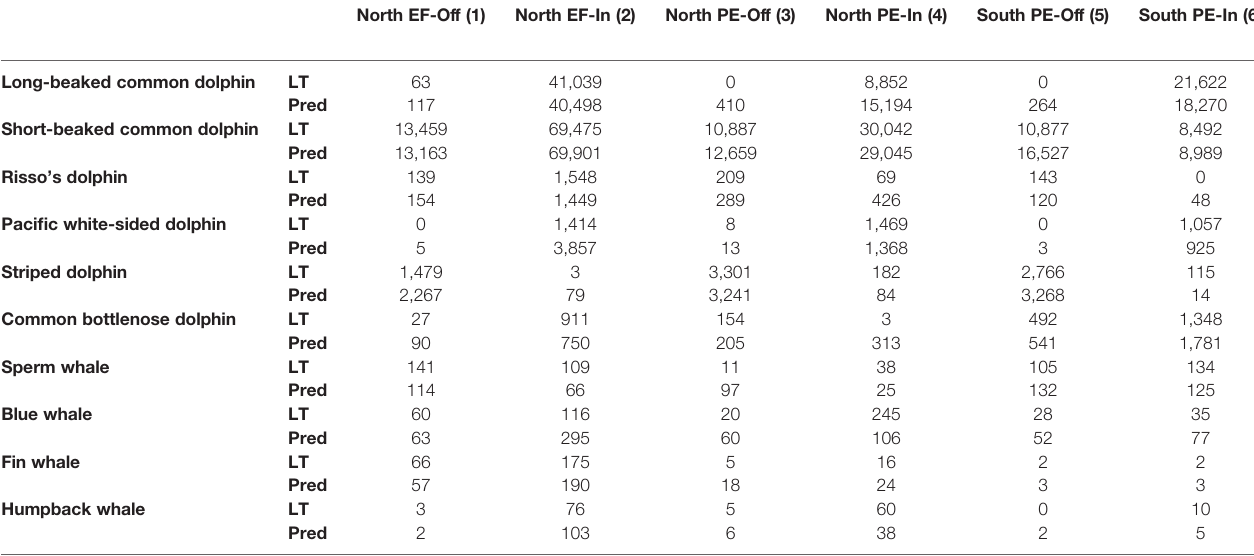
TABLE 4 | Relative abundance (de fi ned as the encounter rate multiplied by the group size, without correcting for detection probability) as predicted from the models (Pred) and derived from standard line-transect analyses (LT) for the six geographic strata de fi ned for the Southern California Current study area. North EF-Off